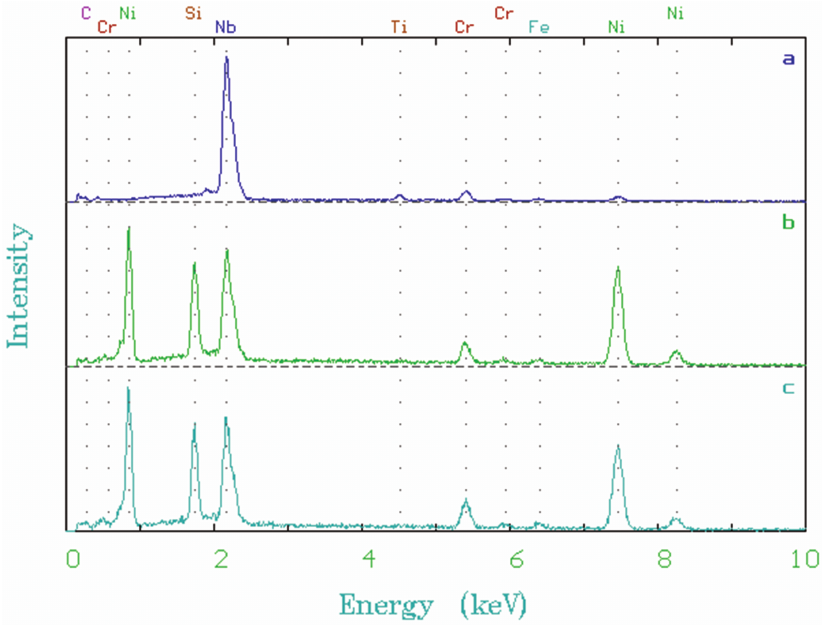
Figure 6: EDX spectra of selected area analyses of the niobium rich carbides in the as-cast (a) and aged for 500 (b) and 1000 h